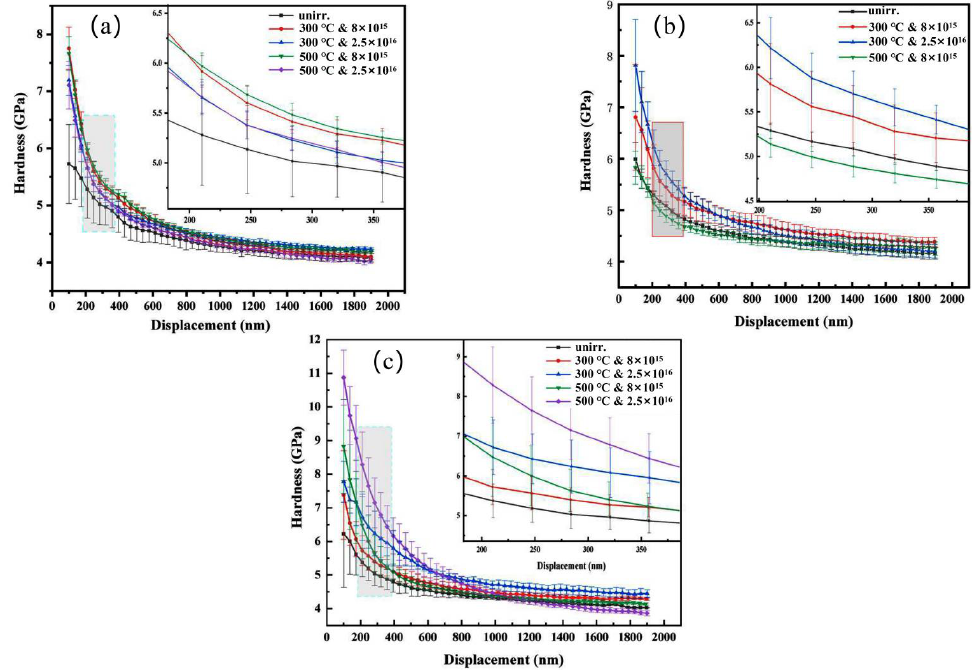
Figure 6. Variation of hardness with indentation depth before and after Fe 11+ irradiation at different ion influences and temperatures: ( a ) Zr 40 Nb 35 Ti 25 , ( b ) Zr 50 Nb 35 Ti 15 , and ( c ) Zr 60 Nb 35 Ti 5 . The hardness decreases along with the depth in both irradiated and un-irradiated samples due to the indentation-size effect, that can also lead to the hardness value increas- ing with decreasing indentation size. In our work, the specimens were prepared with vi- bration polishing, which produced a smooth and deformation-free surface with minimal surface irregularity. Hence, the data within 100 nm are not shown since the near-surface hardness data exhibit a large scatter due to the surface irregularities [37], and indentations depth was controlled to the same depth at 1900 nm for all materials to remove the size effect [38]. It was demonstrated that the largest region of the near-surface ion irradiation region, which is independent of the underlying unirradiated substrate, corresponds to an indenter depth of 350 nm [28]. This is due to the fact that the elastic stress fields beneath the indenter are sensitive to microstructure features that are up to 10-fold the indenter depth. In order to conduct a quantitative analysis of the nanoindentation hardness of the ion irradiation specimens, indenter depths ranging from 200 to 400 nm were utilized. Fig- ure 6a shows that the irradiated Zr 40 Nb 35 Ti 25 MEA sample has a larger hardness than the unirradiated sample with the increase the irradiation fluence and temperature. Figure 6b shows that the irradiated Zr 50 Nb 35 Ti 15 MEA sample’s hardness also increases, except for the sample irradiated with 8 × 10 15 ions/cm 2 at 300 °C. Instead, Figure 6c shows that the Zr 60 Nb 35 Ti 5 MEA has a smaller hardness than the unirradiated, and the irradiated for 8 × 10 15 ions/cm 2 at 500 °C. has no obvious variation. The magnitude error bar is attributed to scattering and difficulty in fitting the data shown in Figure 6. Figure 7 illustrates the Nix– Gao model for three MEAs. The result is the same as its indentation depth profiles.